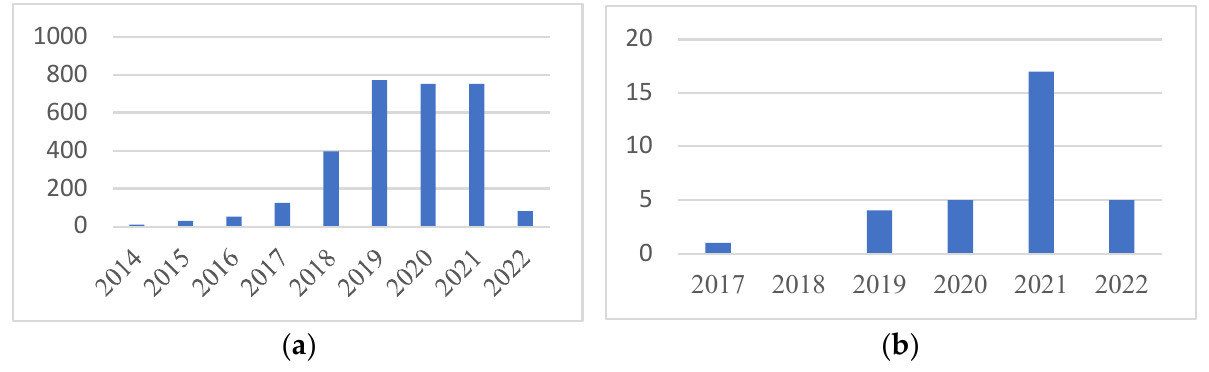
Figure 1. Number of articles related to cryptocurrency ( a ) and non-fungible tokens ( b ), 2014–2022 (February), Web of Science. Source: authors elaboration.